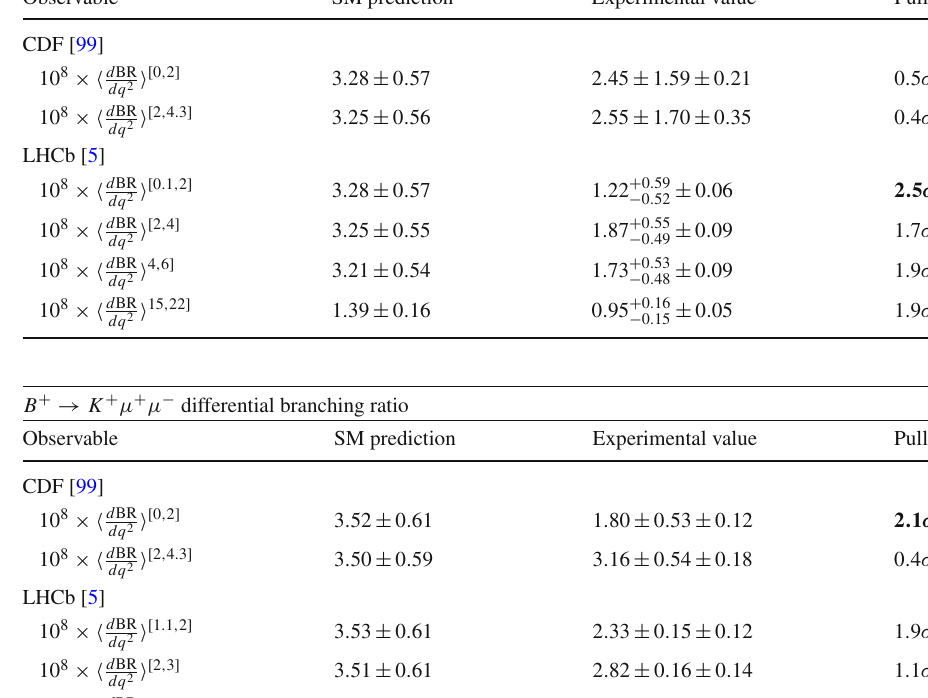
branching ratio of B 0 → K 0 μ + μ − included in the global fit